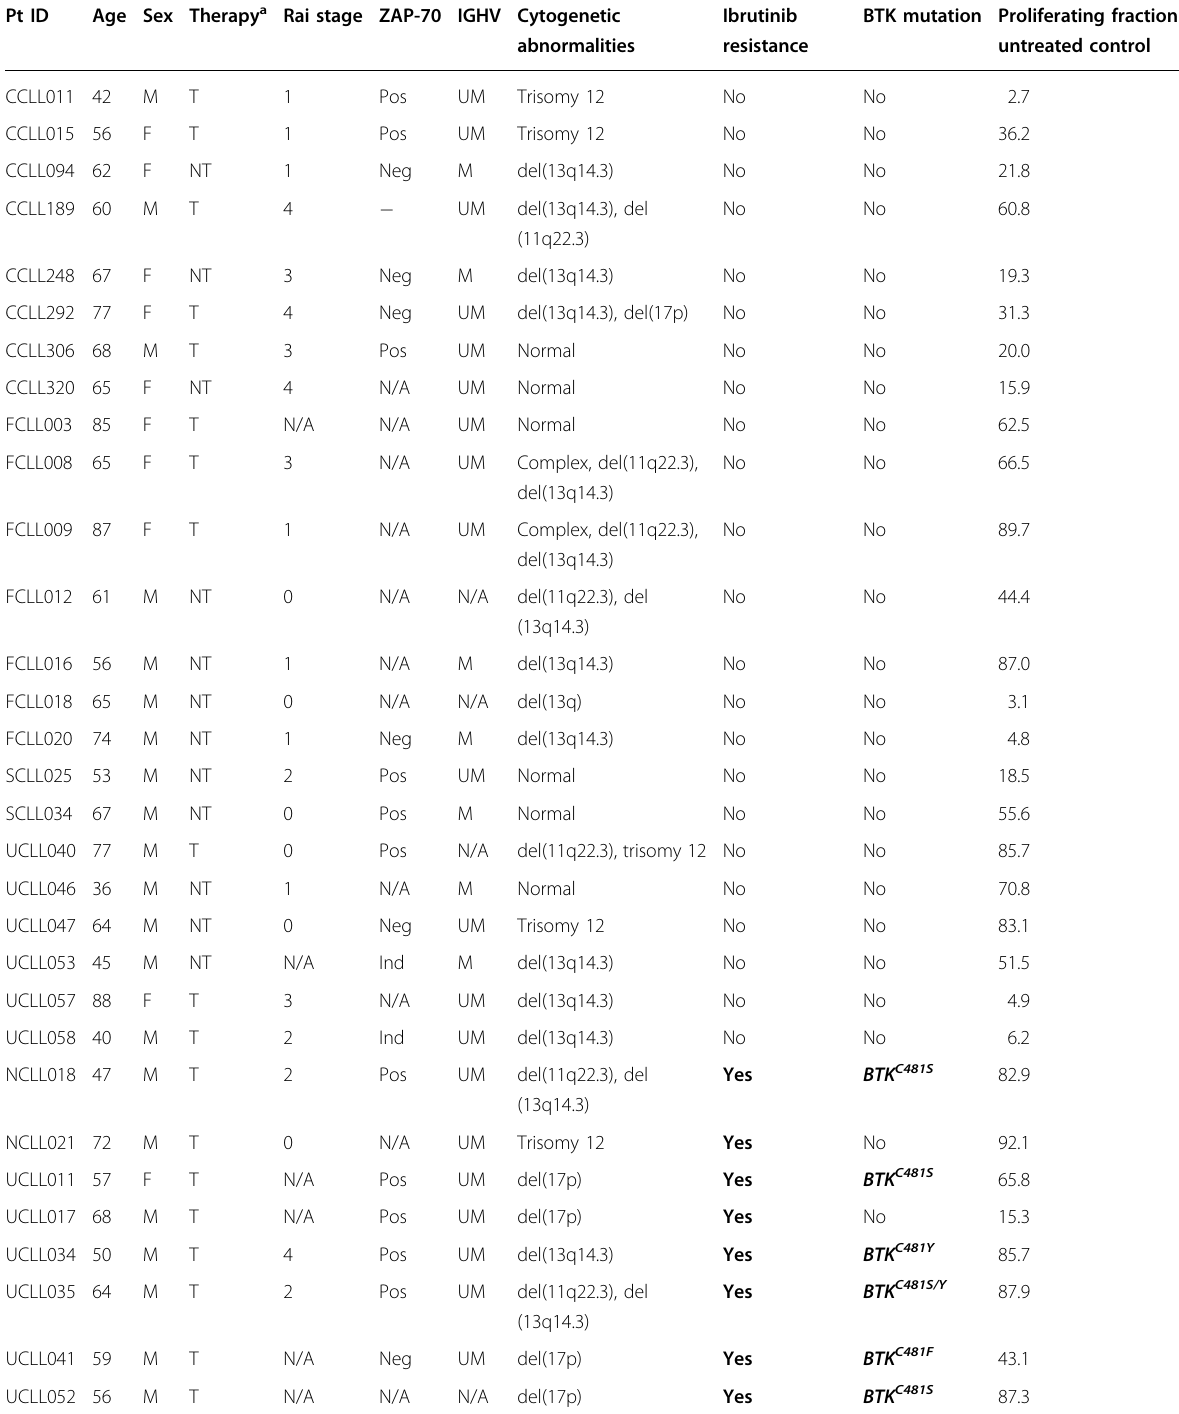
Table 1 Patient clinical and pathological characteristics. Pt